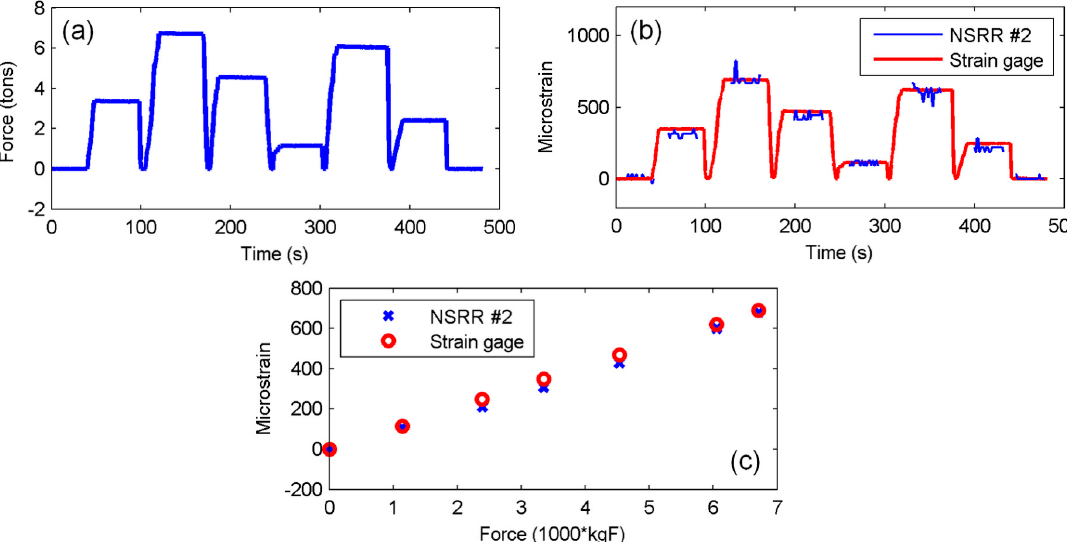
Figure 7. Discrete-time measurements: ( a ) applied force levels; ( b ) strain read by the sensing system with NSRR #2 and by strain gages, plotted versus time; and ( c ) average of the strain values for each force level, plotted versus the force.